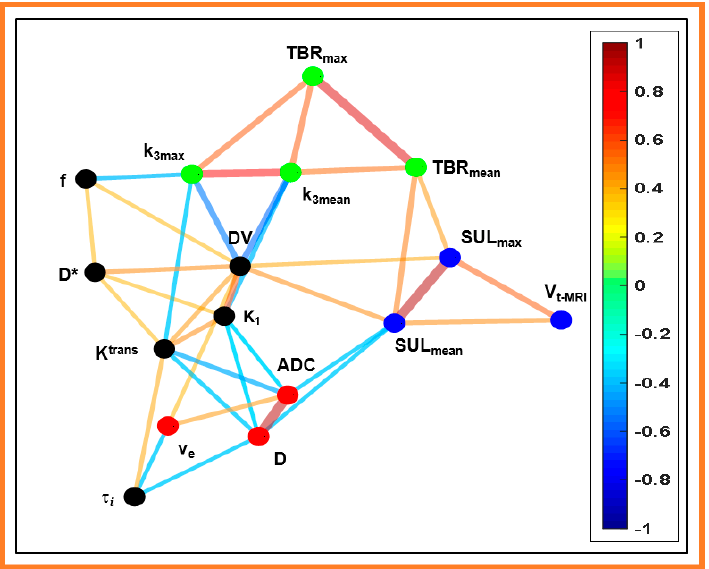
Figure 7. Sample network with 16 nodes and 33 edges constructed from a community detection algorithm (CDA) based on the spin-glass model. The nodes represent the quantitative imaging (QI) metrics derived from four multimodality imaging which are connected by lines or edges in the graph. The perfusion metric, K 1 , and distribution volume (DV) derived from the 18 FMISO-PET/CT overlap with DW- and DCE-MRI metrics and are densely interconnected compared to other metrics in the network ( blue color: 3 nodes [V t-MRI , SULmax, mean], green color: 4 nodes [TBR max , mean, and k 3max,mean ] black color 6 nodes [K 1 , DV, D* and f, K trans and τ i ], and red color: 3 nodes [ADC, D, and v e ]). A solid blue line represents the negative correlation, whereas the orange and red colors represent the positive correlation among the QIs. The thickness of lines indicates the extent of a correlation (weak, moderate, and strong). The value in the color bar scale represents either negative or positive links detected by the CDA approach in